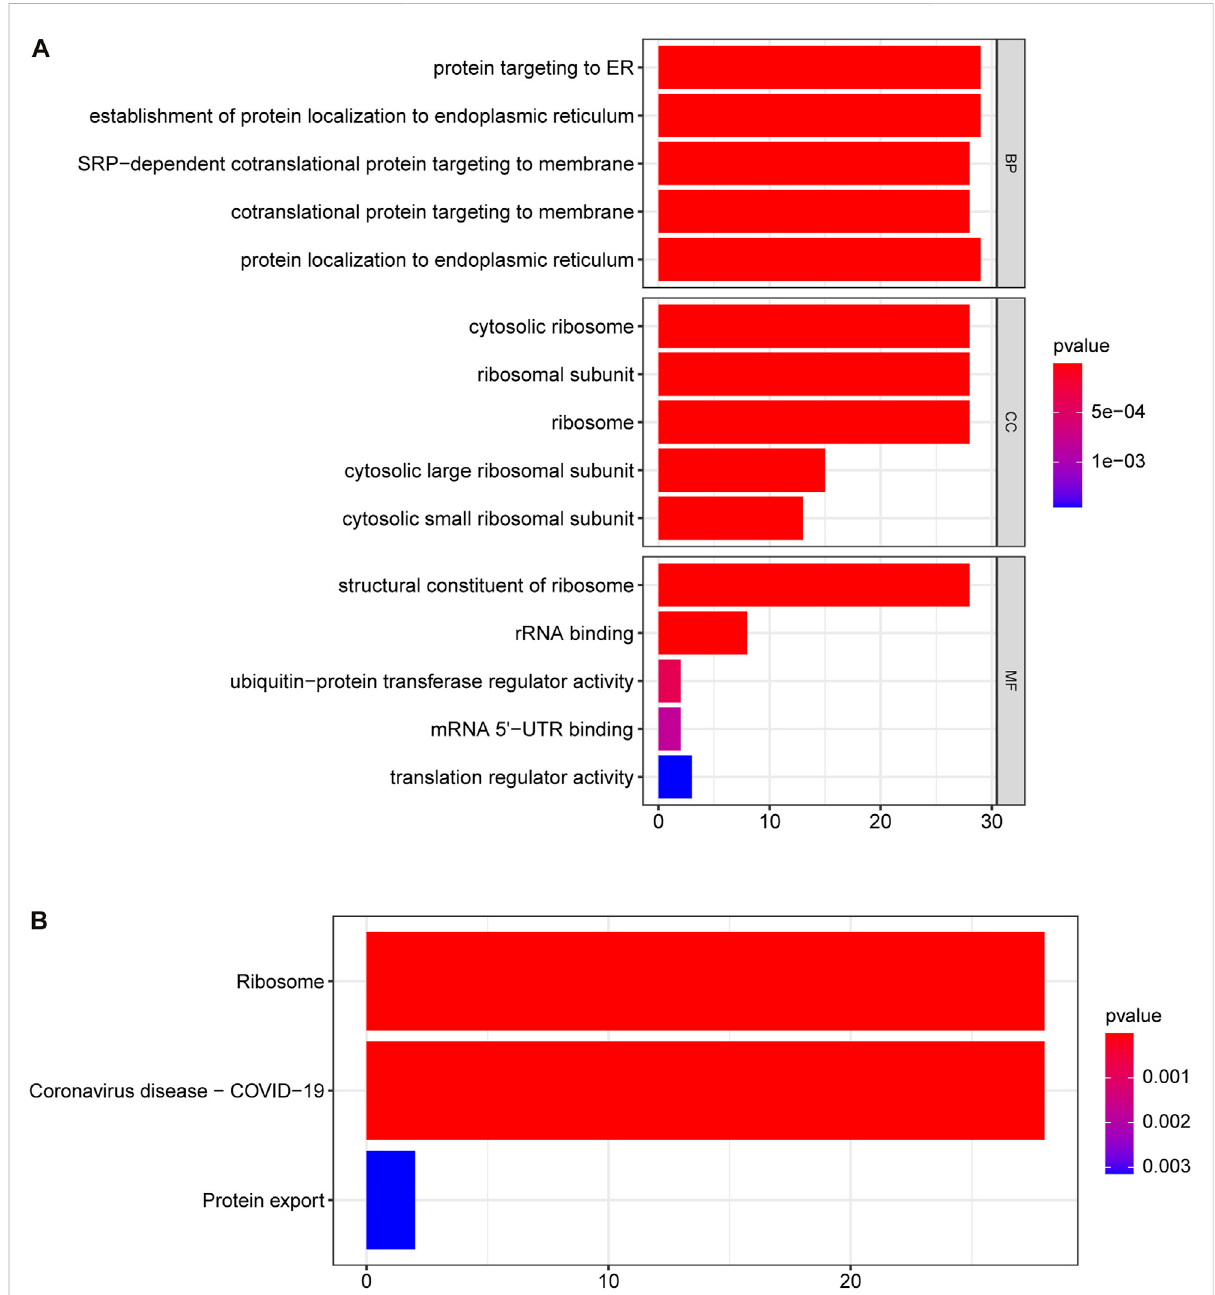
FIGURE 4 GOannotationandKEGGenrichmentanalysisof30DE-SRPGs. (A) Top fi veenrichedbiologicalprocesses,cellularcomponents,andmolecularfunctions. (B) The signi fi cantly enriched KEGG pathways. Using a p -value < 0.05 as criteria. BP, biological process; CC, cellular component; MF, molecular